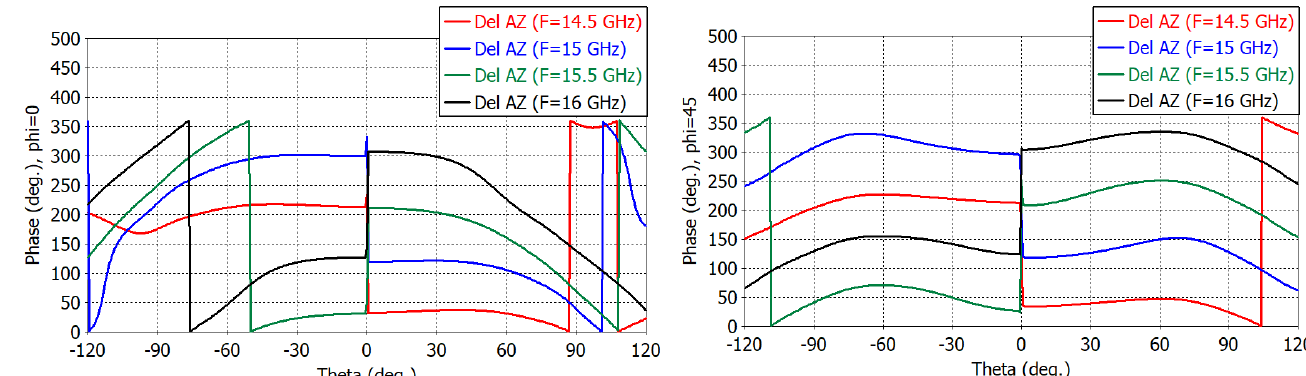
Figure 10. Directivity patterns of the azimuth difference channel.